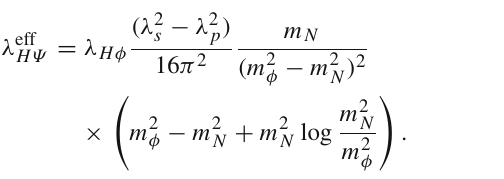
Fig. 1 Left , right elastic cross section diagrams for the scalar and fermion Dark Matter cases, respectively